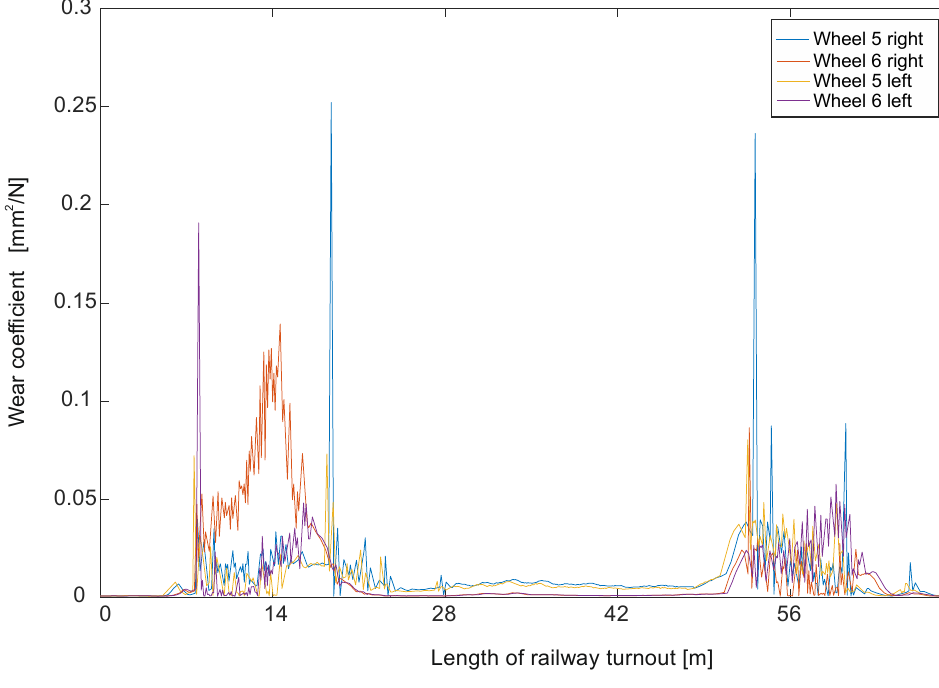
Figure 30. Wear coefficient at 200 km/h on a straight track with a turnout.